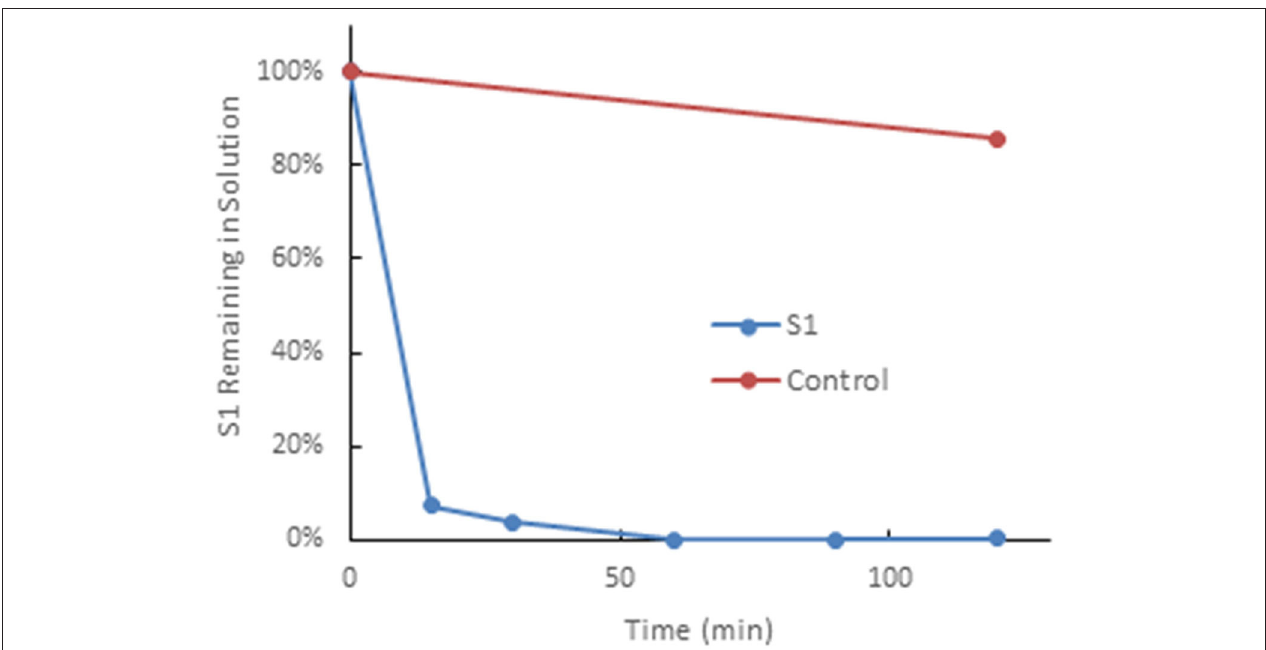
FIGURE 1 | The Hemopurifier captures SARS-CoV-2 spike glycoproteins. This experiment was performed by circulating a solution spiked with the S1glycoprotein of SAR5-COV-2 over the mini-Hemopurifier column in vitro. Briefly, 10 mlof a 1 µ g/ml solution of SAR5-COV-2 S1 in phosphate buffered saline was circulated over a Hemopurifer column containing 0.7g of affinity resin at a flow rate of 50 ml/min. The rate of viral S1 capture, expressed as a percentage of S1 remaining in solution vs. time, was established by removing fluid samples at defined time intervals. The control consisted of S1 kept on the benchtop for the duration of the experiment (i.e., not run through the device).